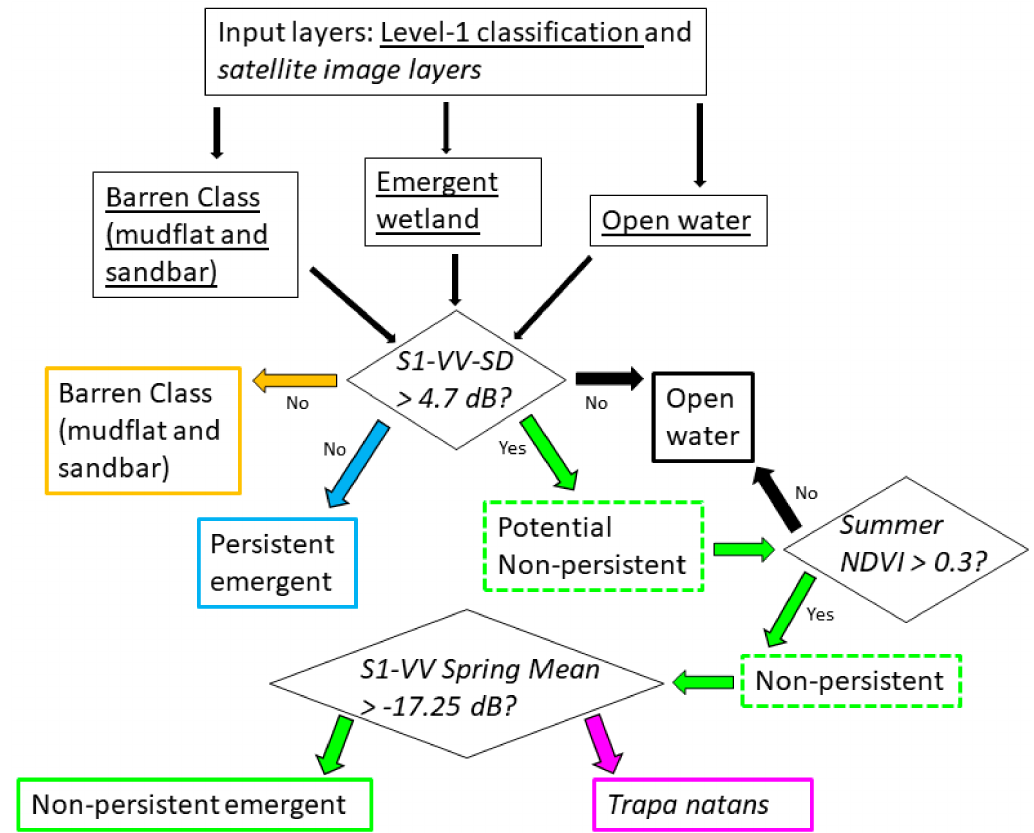
Figure 5. Final level-2 classification for the Mid-Atlantic for 2017. The Gulf Coast level-2 classification utilizes the same methodology but does not separate between aquatics (e.g., T. natans ) and non-persistent emergents. This level-2 classification modifies the existing level-1 classification (shown as underlined text in rectangles) and uses satellite layers (italicized text in diamonds) to classify non-persistent emergent and T. natans . The original level-1 classes are preserved where they do not meet level-2 vegetation classification criteria. The colors on the level-2 classification schematic correspond to classification map colors in Results Sections 3.3 and